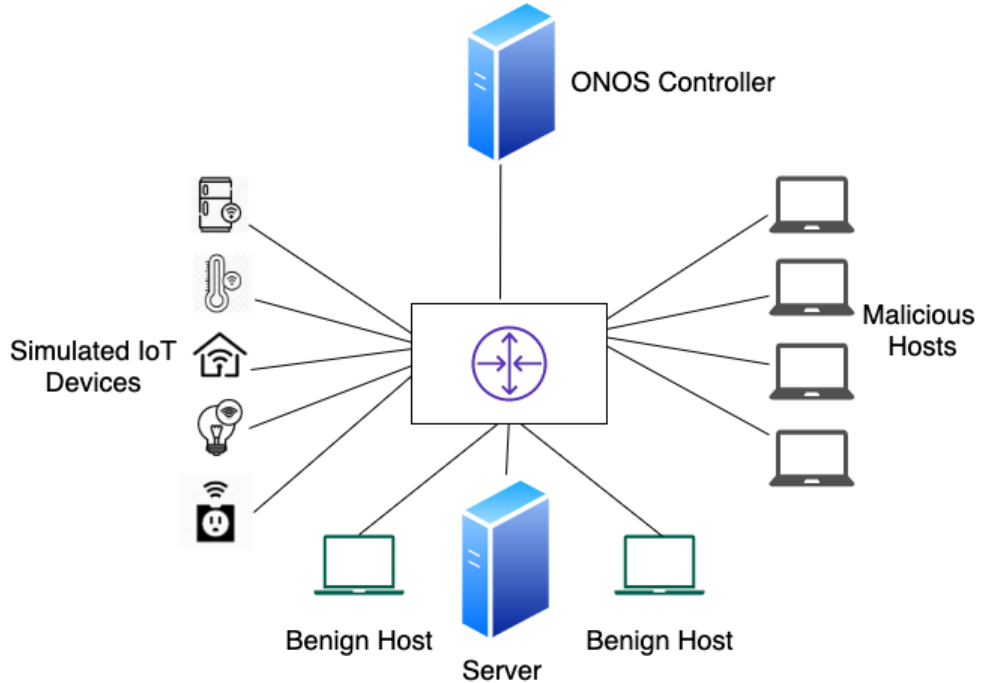
Figure 10. Testbed